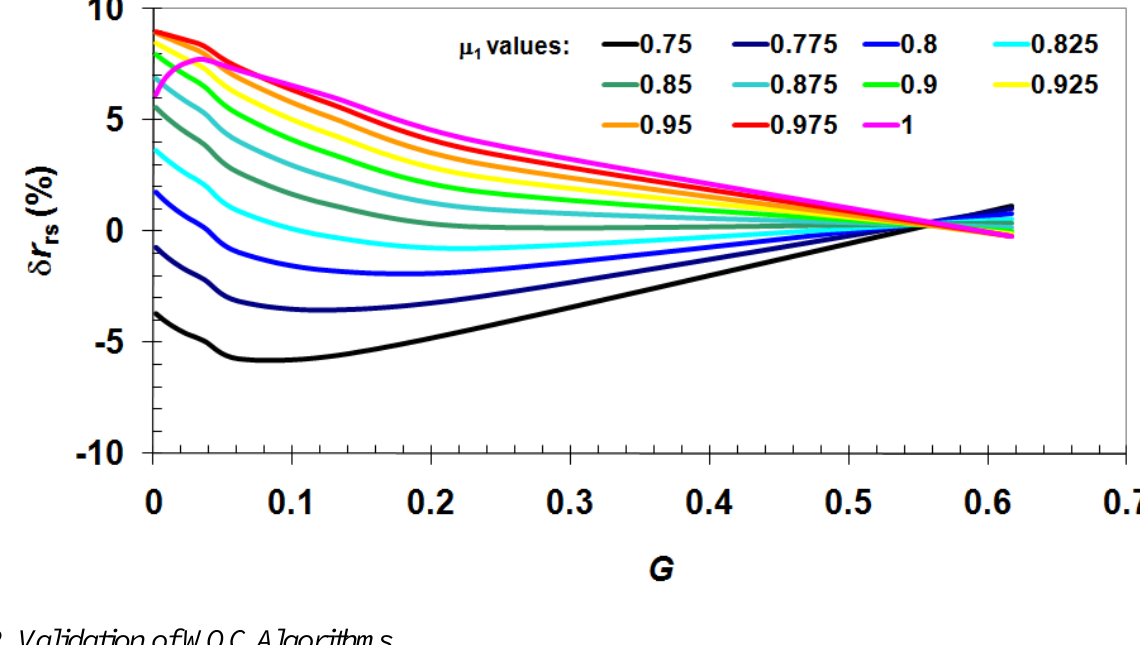
computed by rs = 2